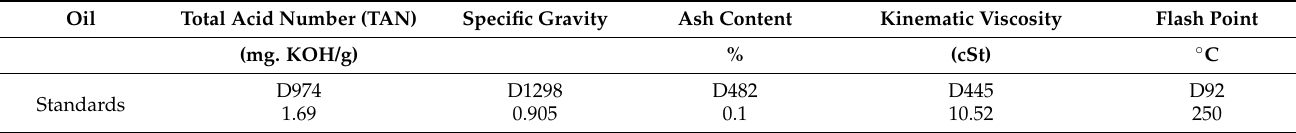
Figure 1. Illustration of test bench. Table 1. Lubricating oil